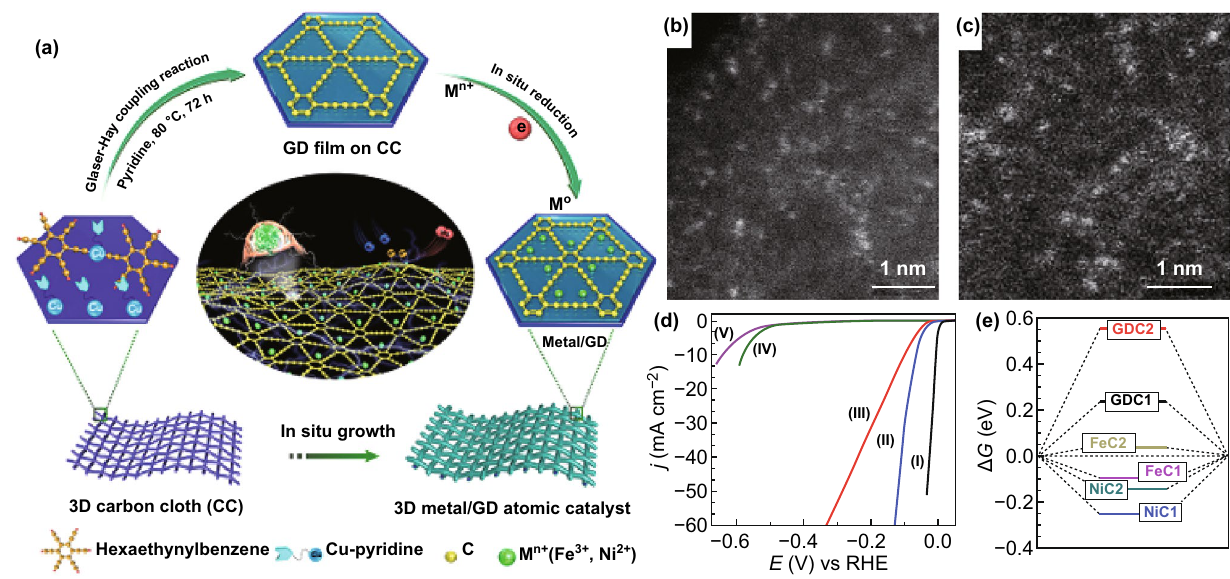
Fig. 15 a Schematic illustration for the synthesis of Fe/GD and Ni/GD. AC-HAADF-STEM images of b Ni/GD and c Fe/GD. d Polarization curves of CC, Ni/GD, GDF, Fe/GD, and Pt/C. e The chemisorption energy of H for HER performance related to the free energy profile (Δ G ). Panels are reproduced from Ref. [155] with permission. Copyright 2018 Nature Publishing